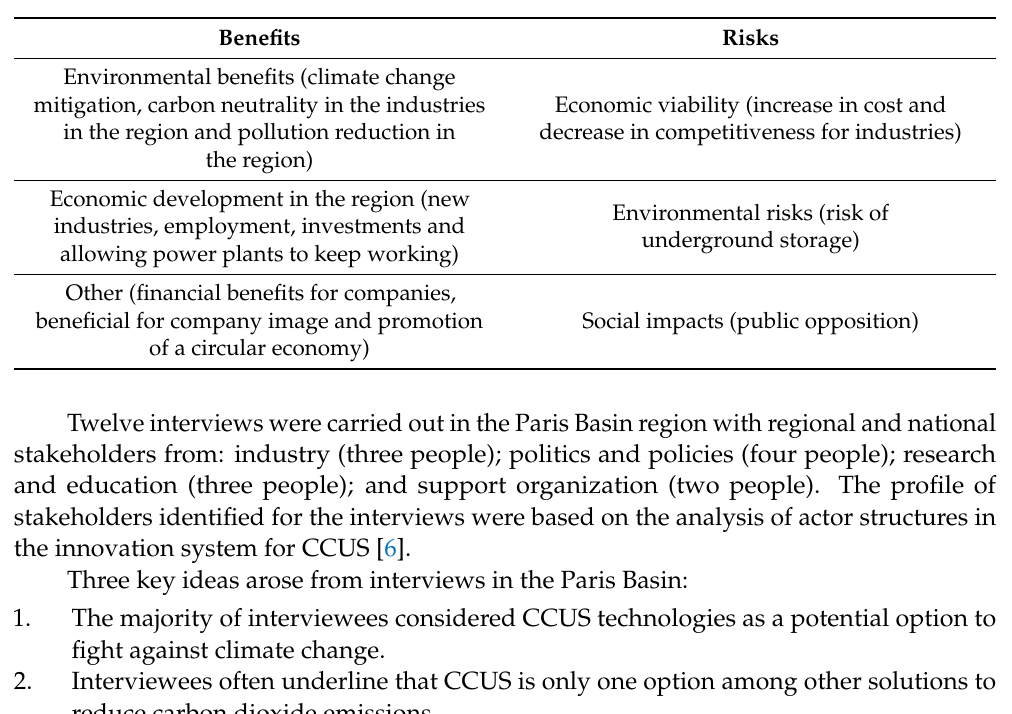
Table 2. List of cited benefits and risks established from interviews in the Paris Basin region. At the top, the most mentioned arguments for both categories, benefits and risks are listed. Benefits Risks Environmental benefits (climate change Economic viability (increase in cost and mitigation, carbon neutrality in the industries decrease in competitiveness for industries) the region) Environmental risks (risk of underground storage)